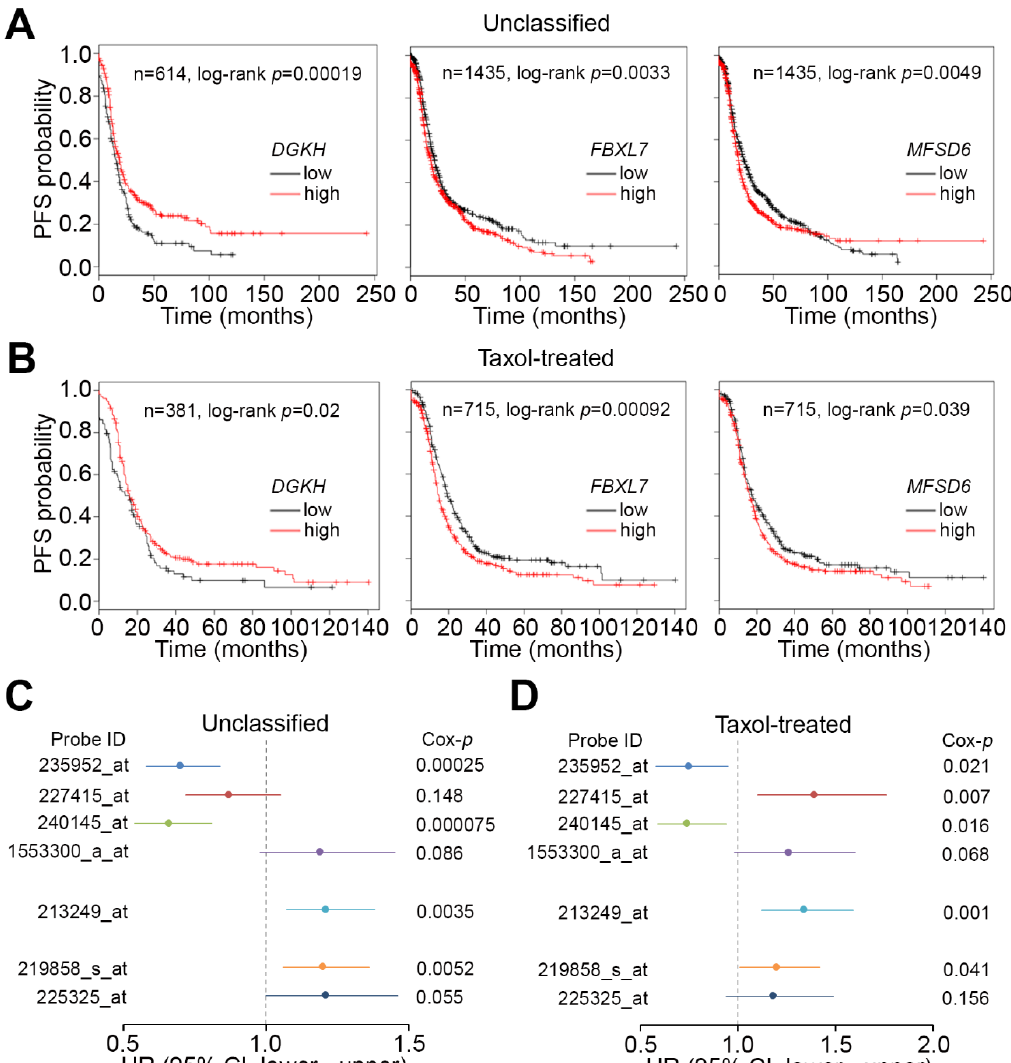
Figure 3. FBXL7 upregulation refers to a poor progression-free survival (PFS) rates in ovarian cancer patients. ( A and B ) K-M analysis for DGKH , FBXL7 , and MFSD6 mRNA expression under the condition of PFS probability in ovarian cancer patients who are unclassified ( A ) or classified into the taxol-treated cohort ( B ) using the K-M Plotter database. ( C and D ) Cox regression test using univariate model against different probe identifiers (ID) for DGKH (235952_at, 227415_at, 240145_at and 1553300_a_at), FBXL7 (213249_at), and MFSD6 (219858_s_at and 225325_at) in a microarray analysis using the K-M Plotter database under the condition of PFS probability. HR denotes hazard ratio.